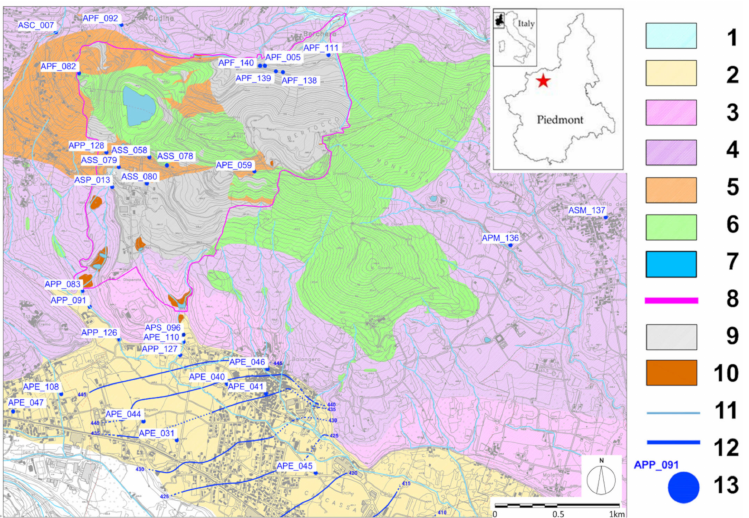
Figure 1. Location of the investigated area. 1 = recent alluvial deposits; 2 = alluvial deposits of the Balangero Plain (Middle–Upper Pleistocene); 3 = fluvioglacial deposits (Middle Pleistocene); 4 = fluvial deposits (Lower Pleistocene); 5 = Sesia-Lanzo zone; 6 = Lanzo Massif serpentinite; 7 = mine pit lake; 8 = remediation site; 9 = tailing piles; 10 = waste sludge; 11 = rivers; 12 = piezometric map of the phreatic aquifer from water table levels measured on Nov. 10–11, 2008 (m a.s.l.) [26]; 13 = monitoring